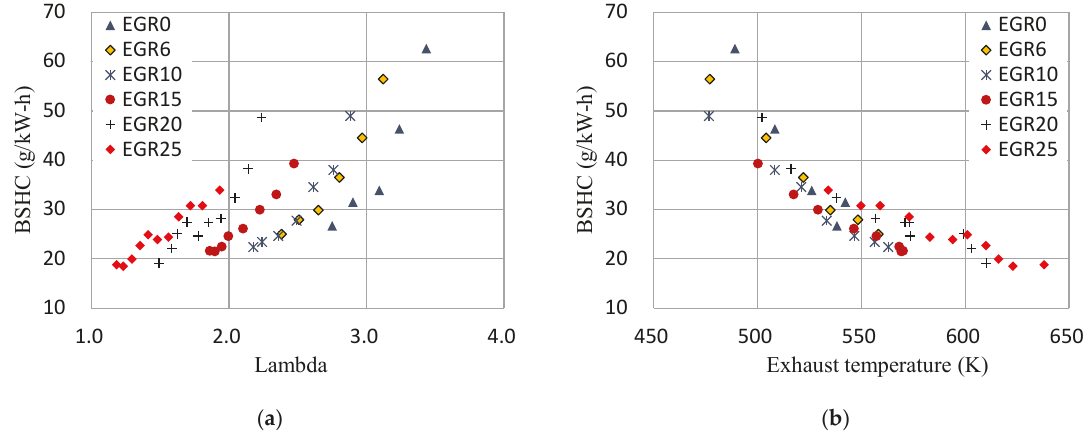
Figure 11. Brake specific HC emission with respect to: ( a ) Lambda; ( b ) Exhaust temperature.